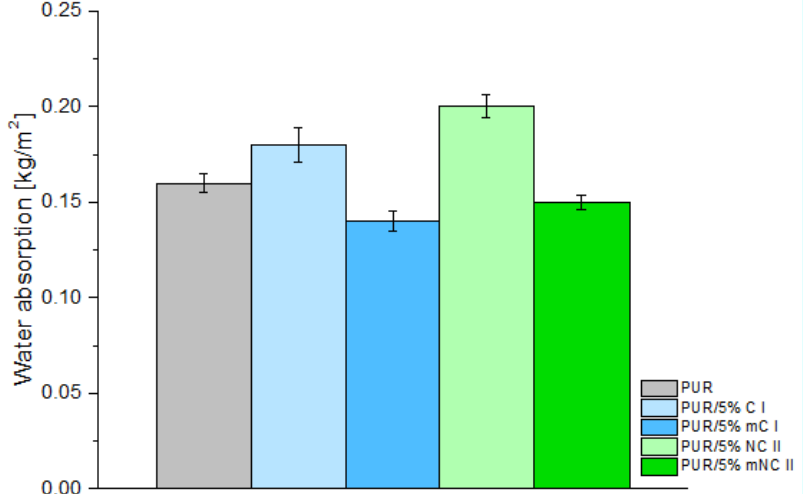
Figure 7. Water absorption of composites depending on filler type (5% loading).